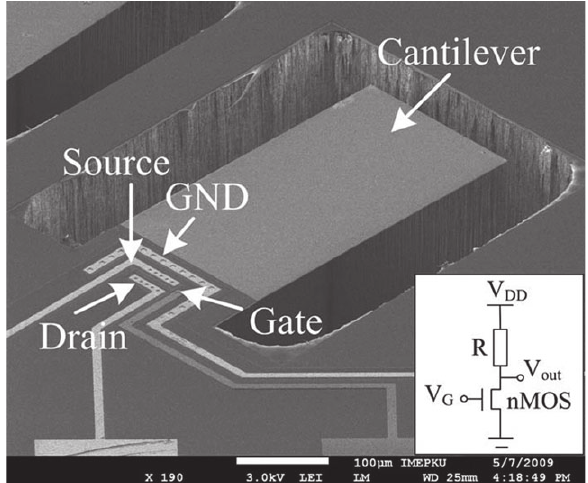
Figure 4 SEM image of an nMOSFET-embedded MC sensor. The inset displays the common-source stage circuit with resistive load, which was used as the measurement circuit in our experiments. Reproduced with permission from Wang et al. (2009)